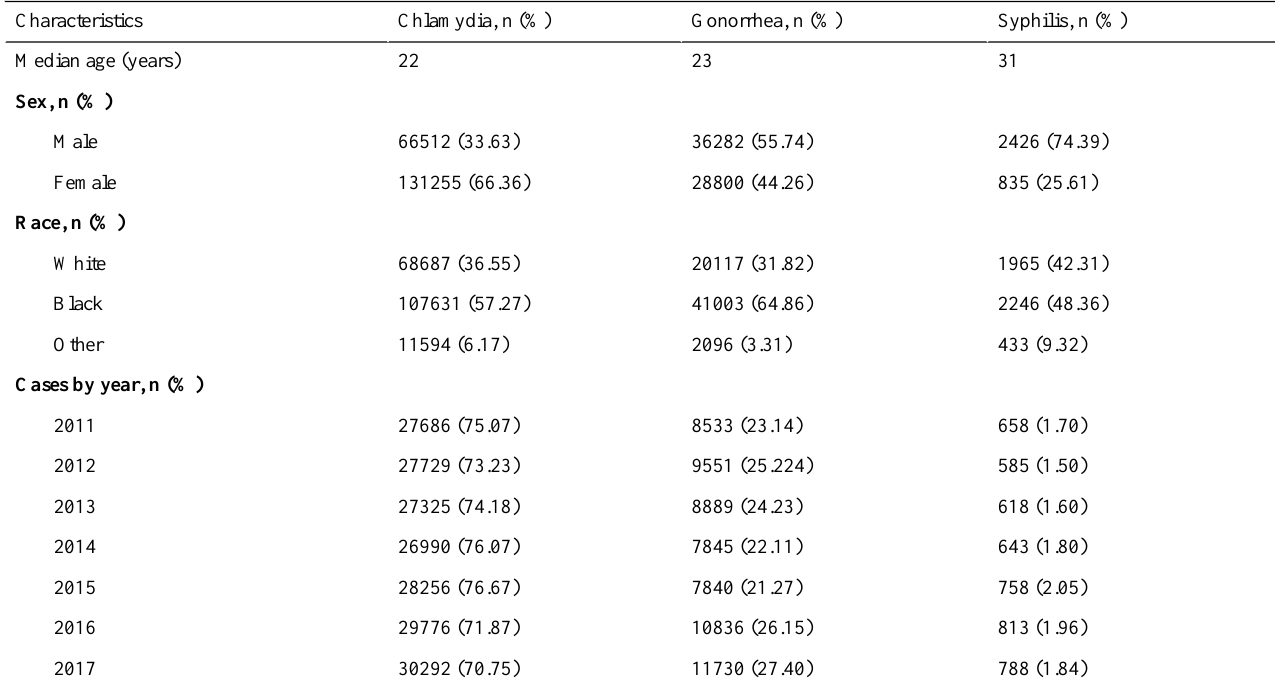
Table 1. Demographic characteristics and number of laboratory–confirmed reported cases of chlamydia, gonorrhea, and syphilis by year for Chicago,